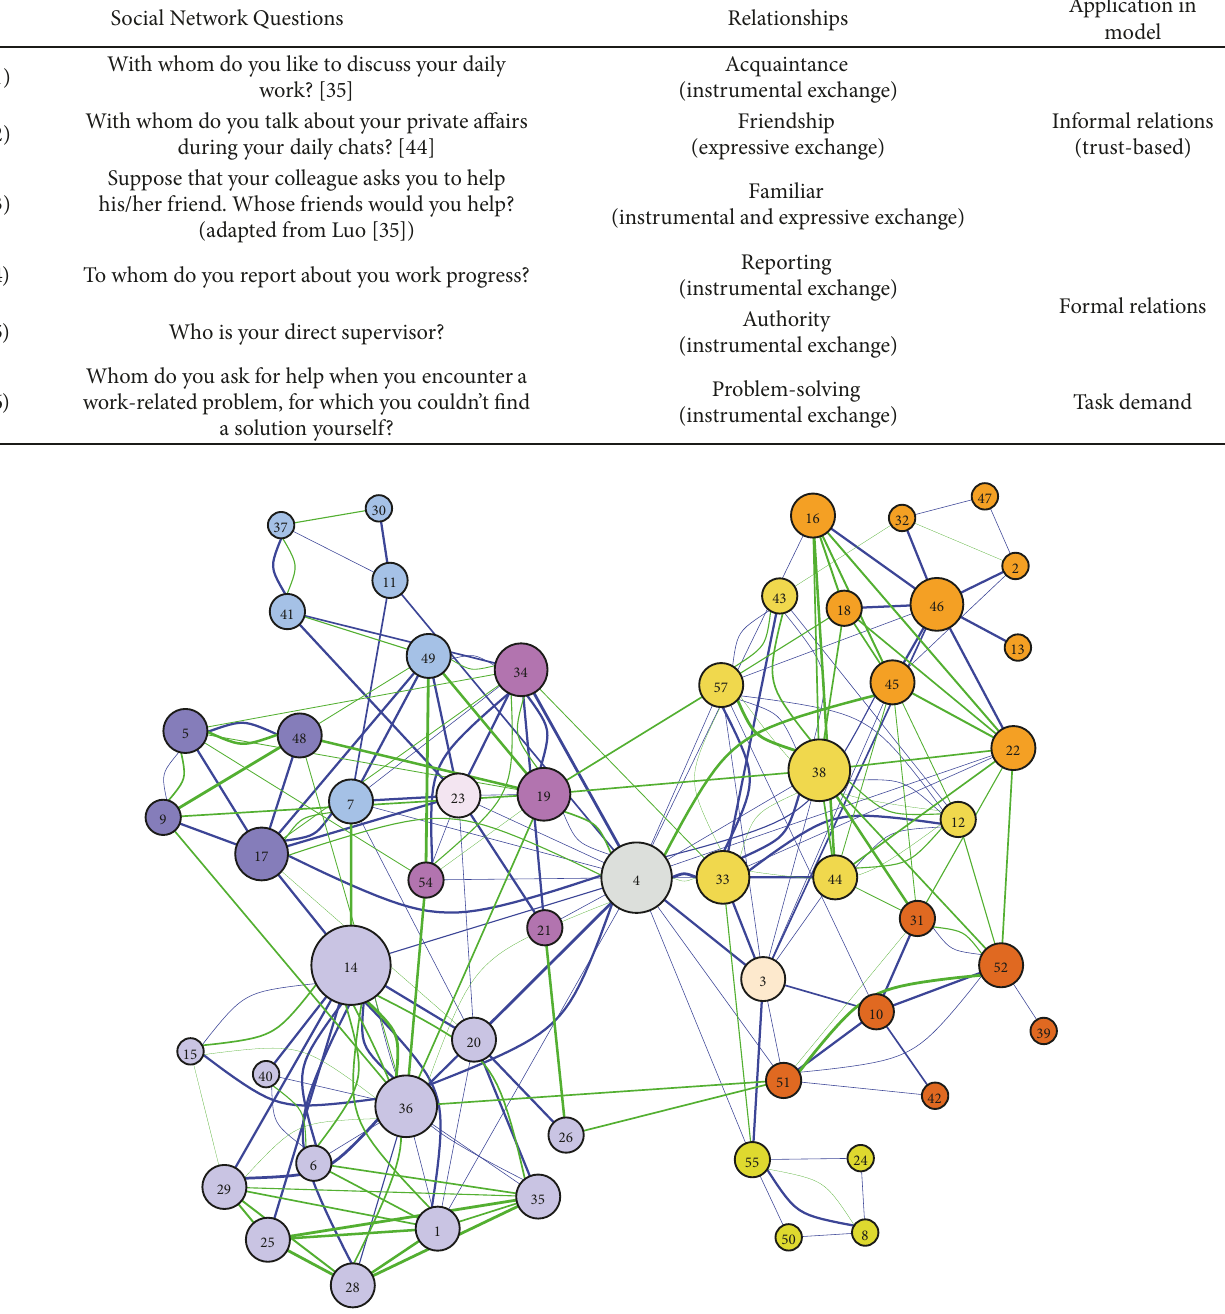
Table 1: Networks data used in the model.